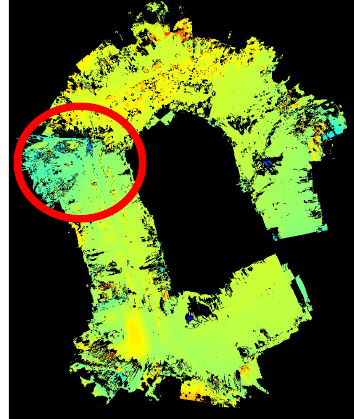
Figure 5. Computed DSM of the test